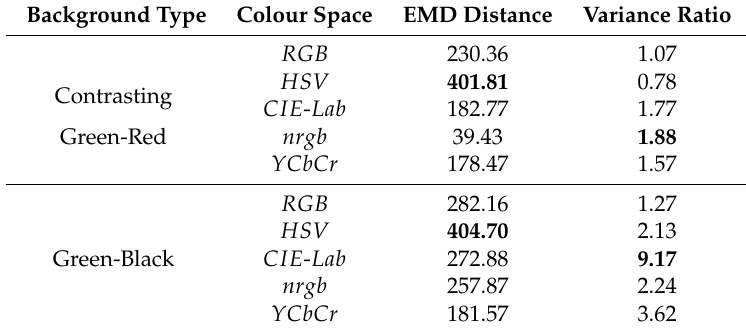
Table 2. Table for different imaging senarios for same plant type. Their computed EMDs on the GMM models in different colour spaces and their comparsion with variance ratio in different colour spaces. EMD based distance are higher for HSV on both background types, where as variance ratios are higher for normalized rgb colour space for contrasting red background and CIE - Lab for the black background.